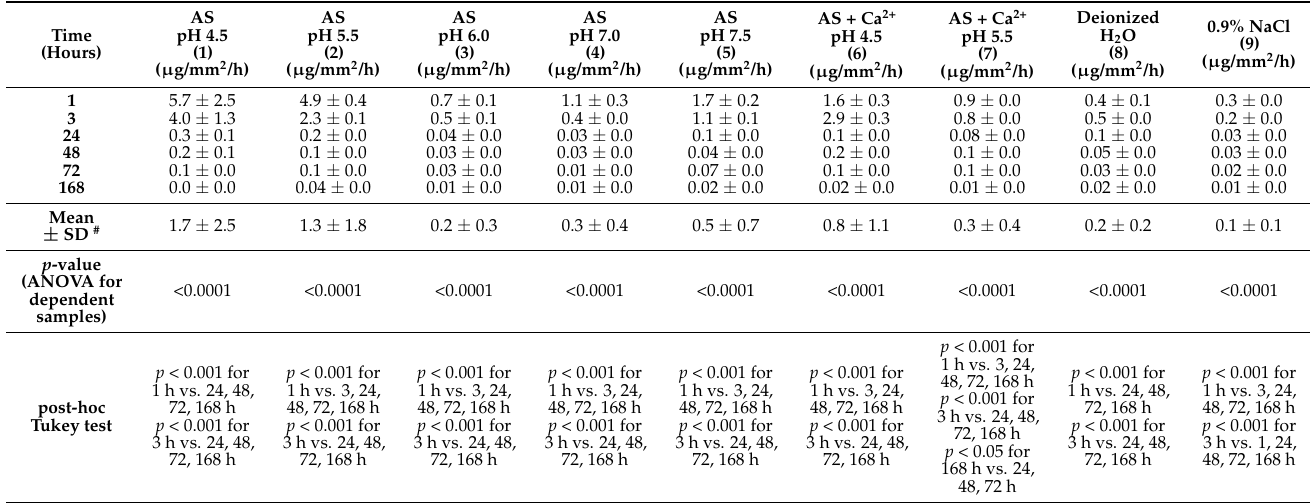
Table 3. Release of fluoride ions ( µ g/mm 2 /h) from compomer Freedom (F) into nine environments differing in composition of the solution and pH. Six samples were prepared for each solution.